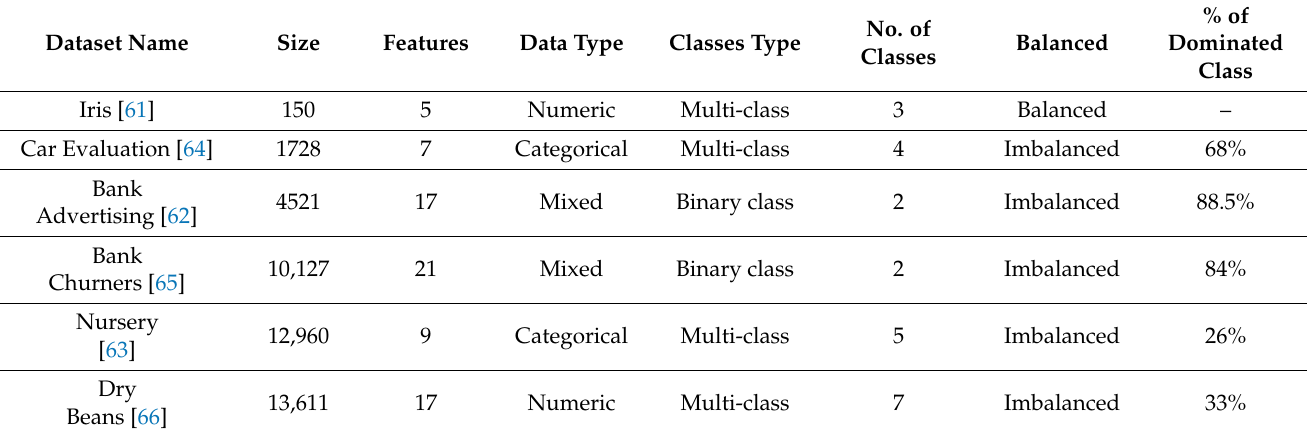
Table 1. Description of the datasets.